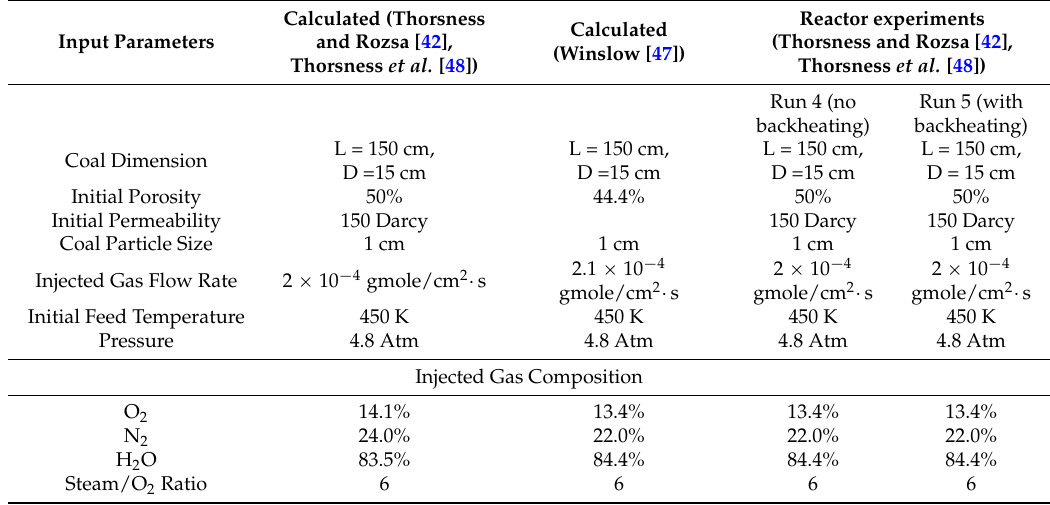
Table 6. Input parameters used for model calculation and experimental runs from a 1.6 m reactor.